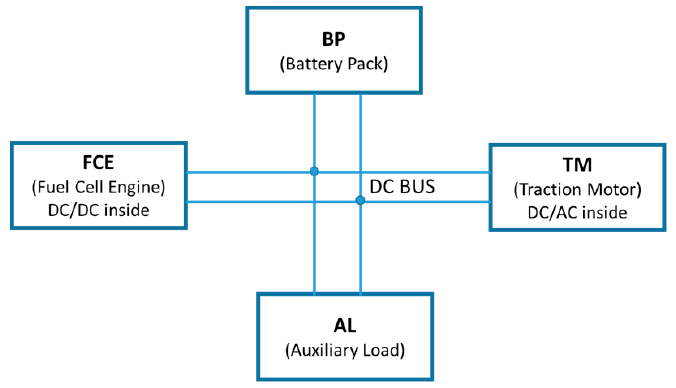
Figure 1. Fuel cell vehicle (FCV) powertrain architecture.